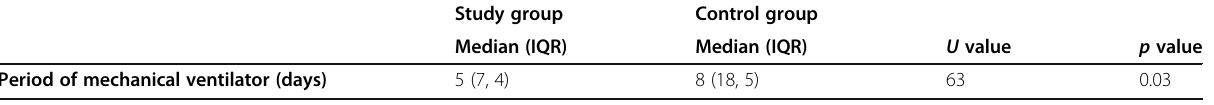
Table 2 Median values of period of mechanical ventilator of study and control groups